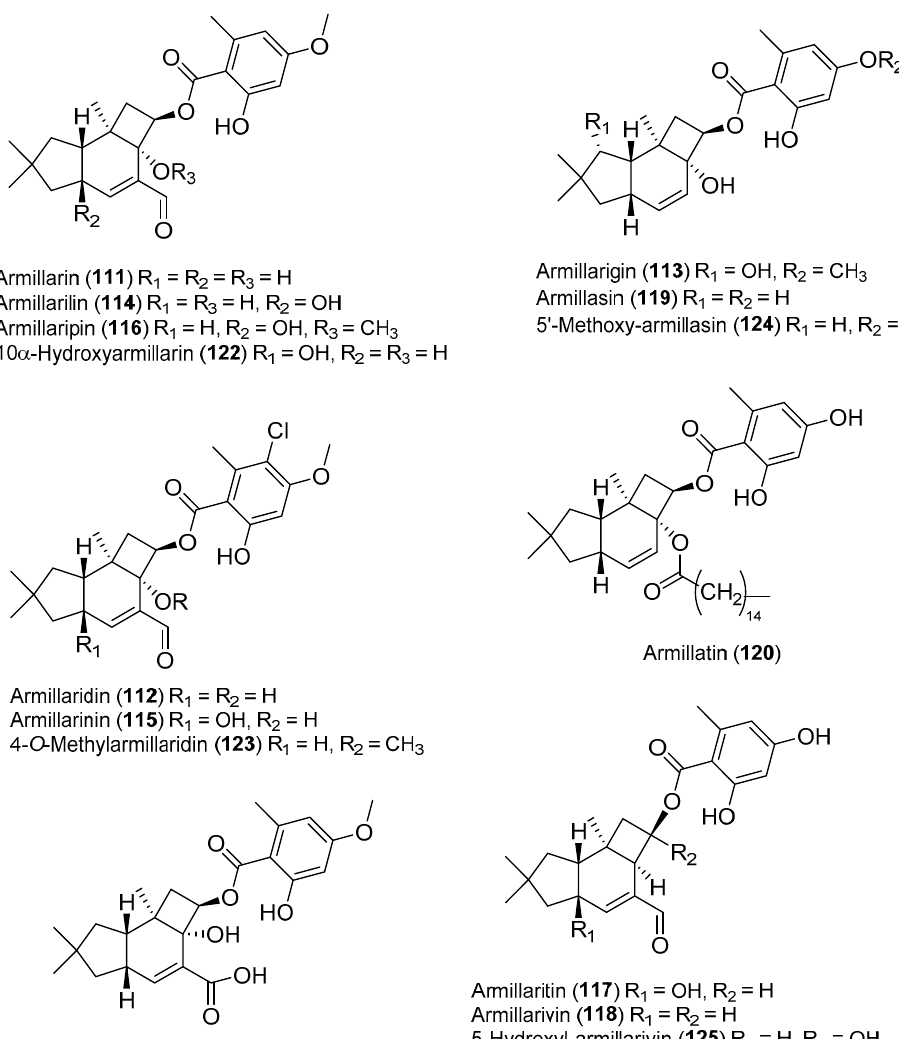
Figure 18. Structures of Δ 2,3 -protoilludene-containing aryl sesquiterpenoids 111 – 125 isolated from Armillaria mellea.